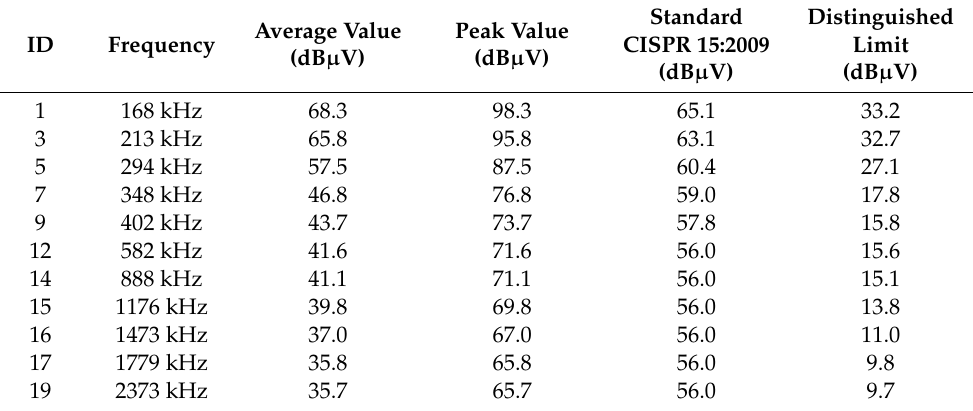
Table 5. Measurements of peak and average value of EMI frequency spectrum.